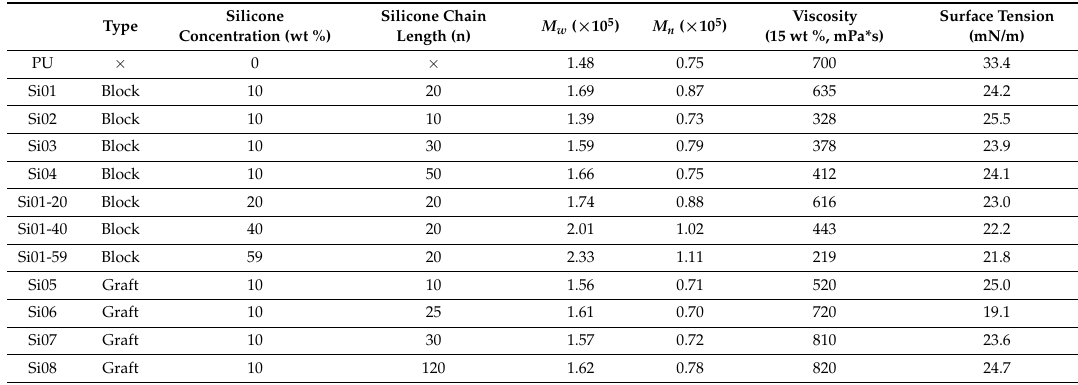
Figure 1. Structures of block type PUSX ( a ) and graft type PUSX ( b ). Table 1. Various parameters (structure, viscosity, molecular weight, and surface tension) of PUSX samples of block type and graft type. ( n =